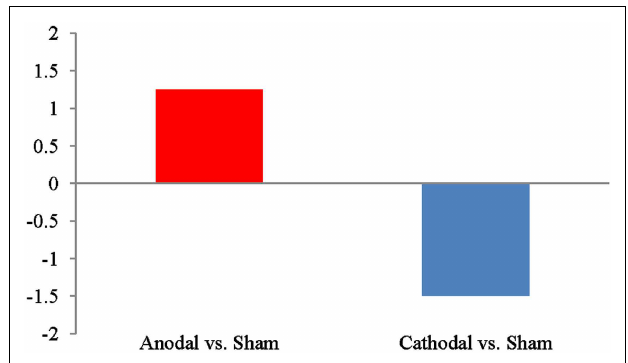
FIGURE 1 | Effects of active stimulation conditions compared to sham stimulation with respect to the numbers of words in clusters during a category-cued fluency task.